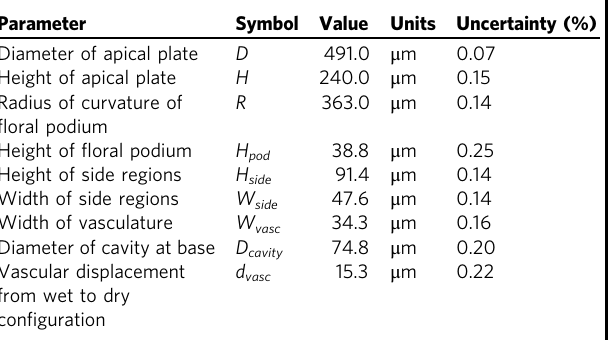
Table 1 List of measured geometrical parameters used to de fi ne the